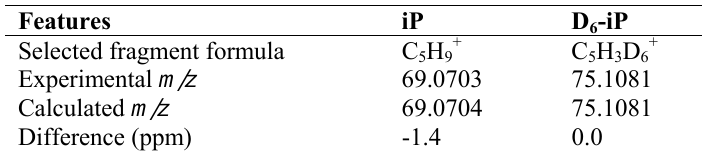
Table 2. The identification of an isopentenyladenine side-chain fragment by exact mass determination using a Q-TOF mass spectrometer. Experimental values are compared to those calculated from the fragments' chemical formulae. The difference between the two values (in ppm) was calculated as a measure of